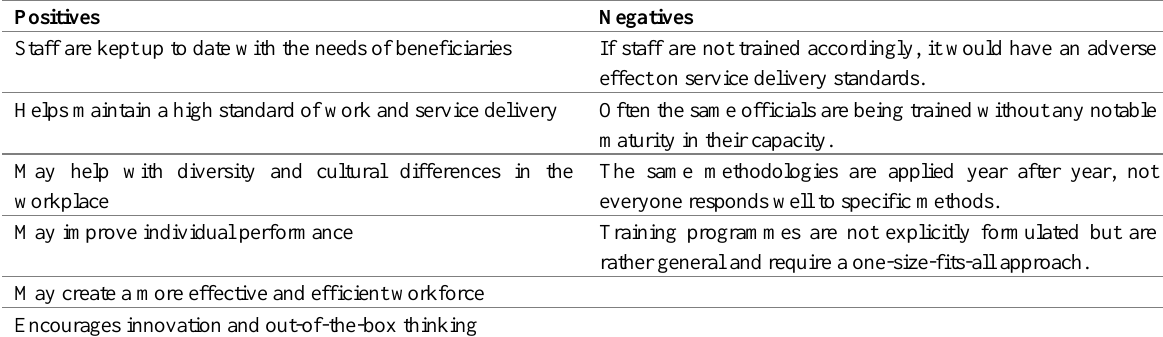
Table 3: Positives and Negatives of Training and